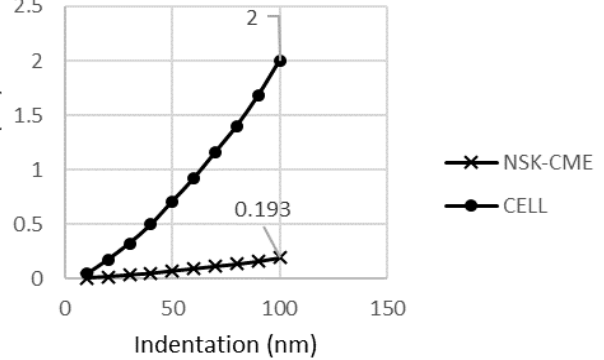
Figure 10. Force-indentation curve for NSK-cytoplasm, membrane, and NE (CME) model vs. the cell.